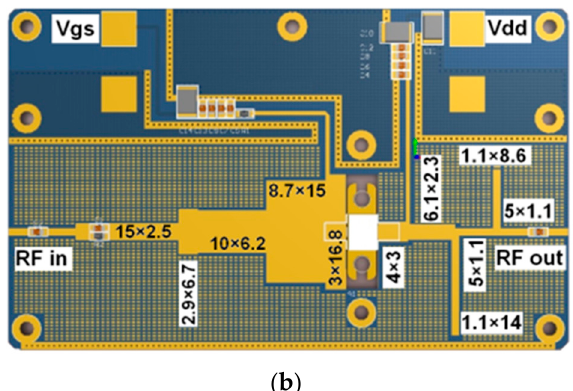
Figure 6. ( a ) Input and output matching network schematic of the proposed PA circuit; ( b ) Matching network layout of the proposed PA circuit.